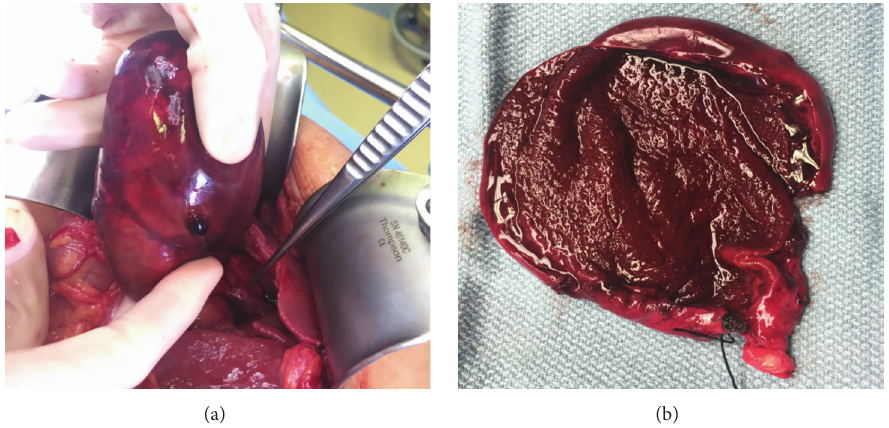
Figure 3: An intraoperative photograph showing the severe distention and discoloration of the gallbladder. This was observed upon entry into the abdomen, the gallbladder was found to be torsed around the cystic duct and cystic artery (shown next to the instrument tip), and there was no other attachment between the gallbladder and the liver. Figure 2(b) shows the gallbladder after it was opened on the back table; no gallstones were found. There was a significant gallbladder wall thickening and